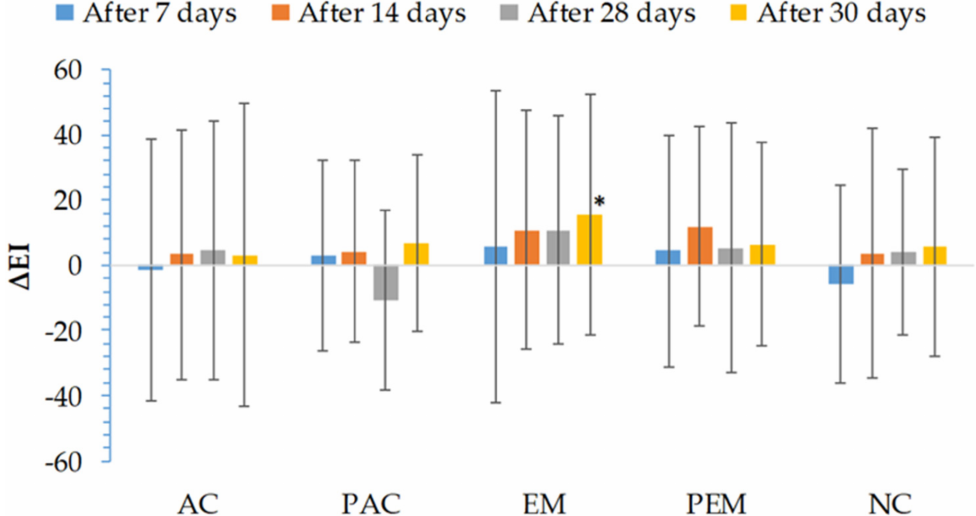
Figure 4. In vivo determined absolute changes relative to basal values of erythema index (EI) for investigated creams (active cream—AC, placebo cream—PAC) and emulgels (active emulgel— EM, placebo emulgel—PEM) after 7, 14, and 28 days of application, and 2 days after cessation of application. Significant differences are marked with * ( p < 0.05).